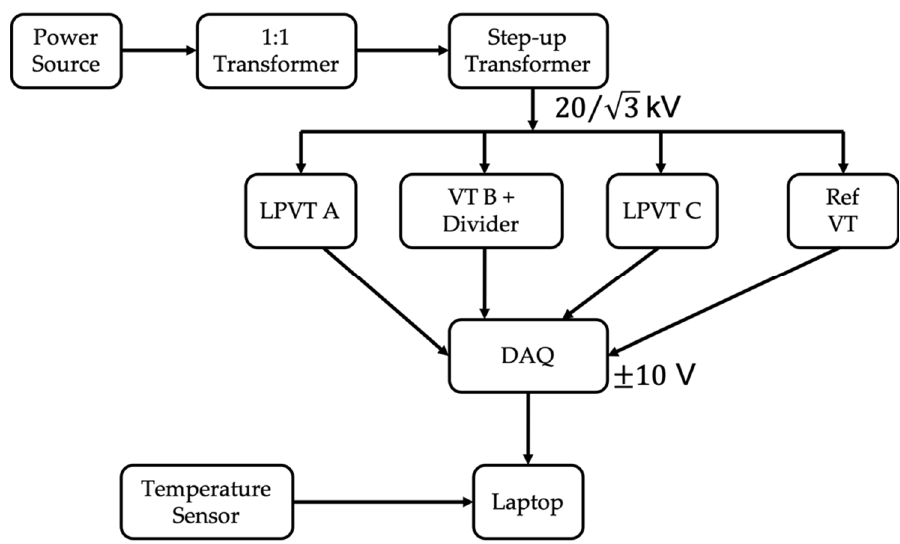
Figure 3. Schematic representation of the measurement setup. Table 1. Main characteristics of the three voltage transformers (VTs) under test.